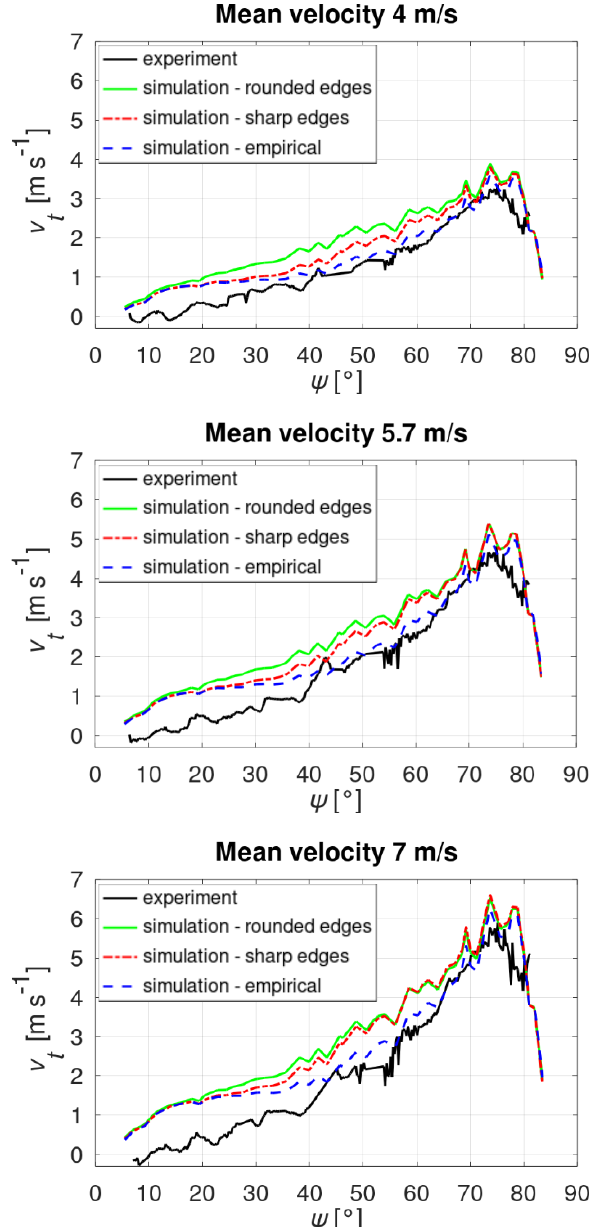
Fig. Tangential velocity 20 mm above the plate . 9.